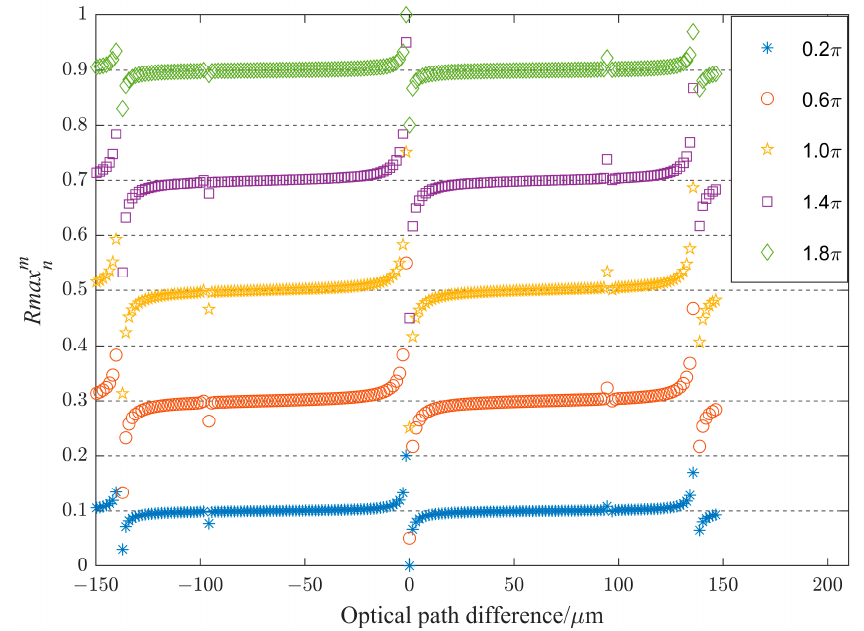
Figure 3. All maximum values a 0 , a 0 . . . a 0 n of the interference term of ϕ = 0 in the range of optical path di ff erence [ − 150 µm,150 µm], and the absolute value of the di ff erence between adjacent maxima ∆ a n .